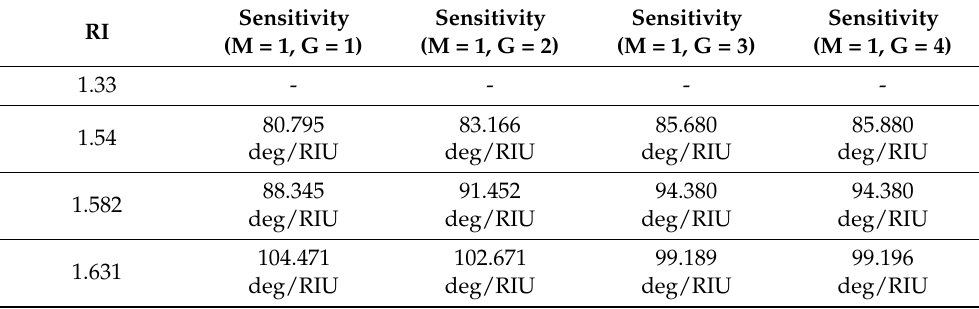
Table 4. Sensitivity computation when the number of MoS 2 layers varies with a single MXene